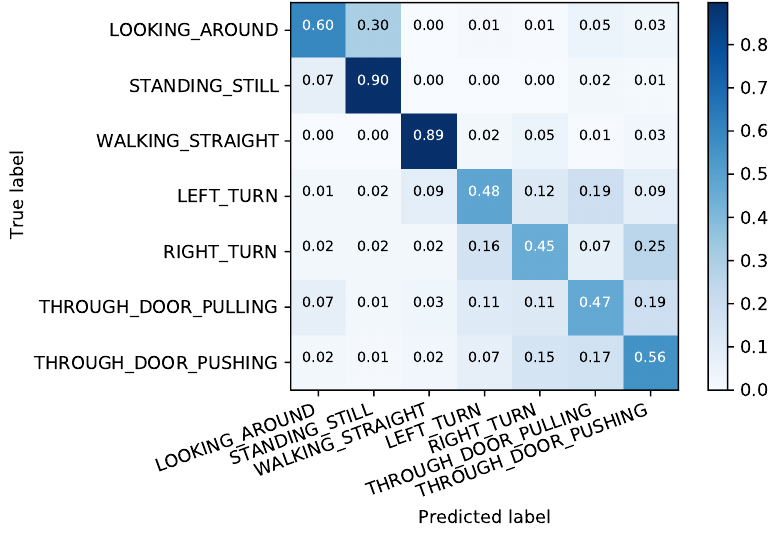
Figure 8. Classification accuracy for the all activities